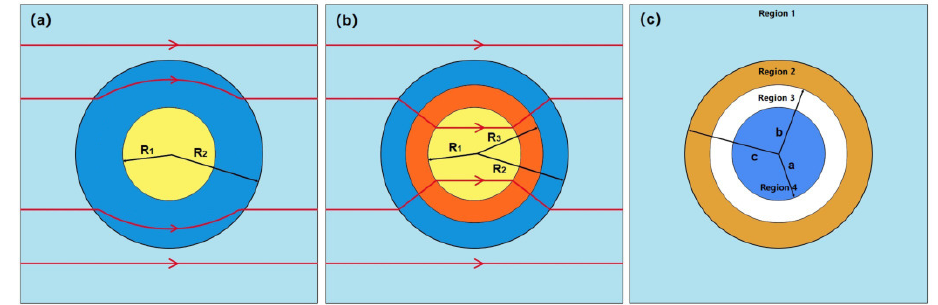
Figure 1. ( a ) Schematic graph shows the cloak device and the trace of the heat flux/electric currency affected by it. ( b ) Schematic graph shows the concentrator device and the trace of the heat flux/electric currency. ( c ) The design of a bilayer